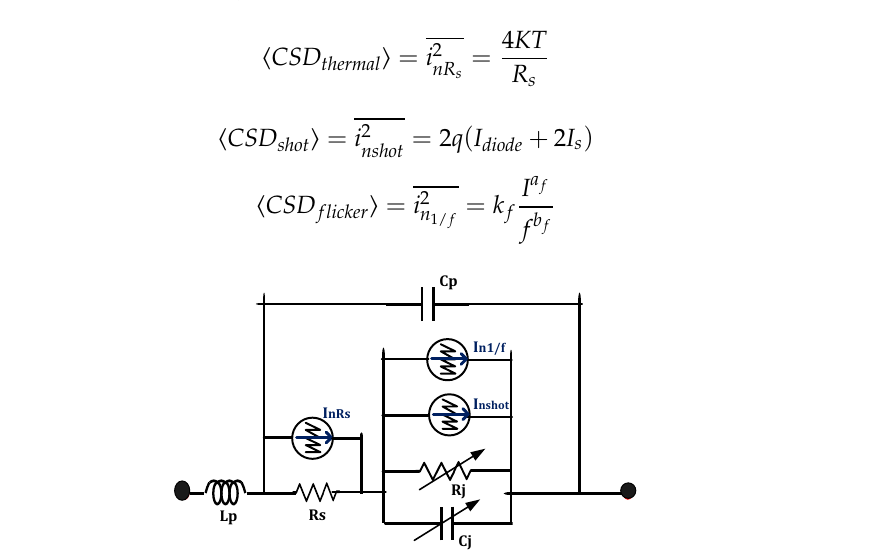
Figure 15. Insertion of noise sources in the diode model.